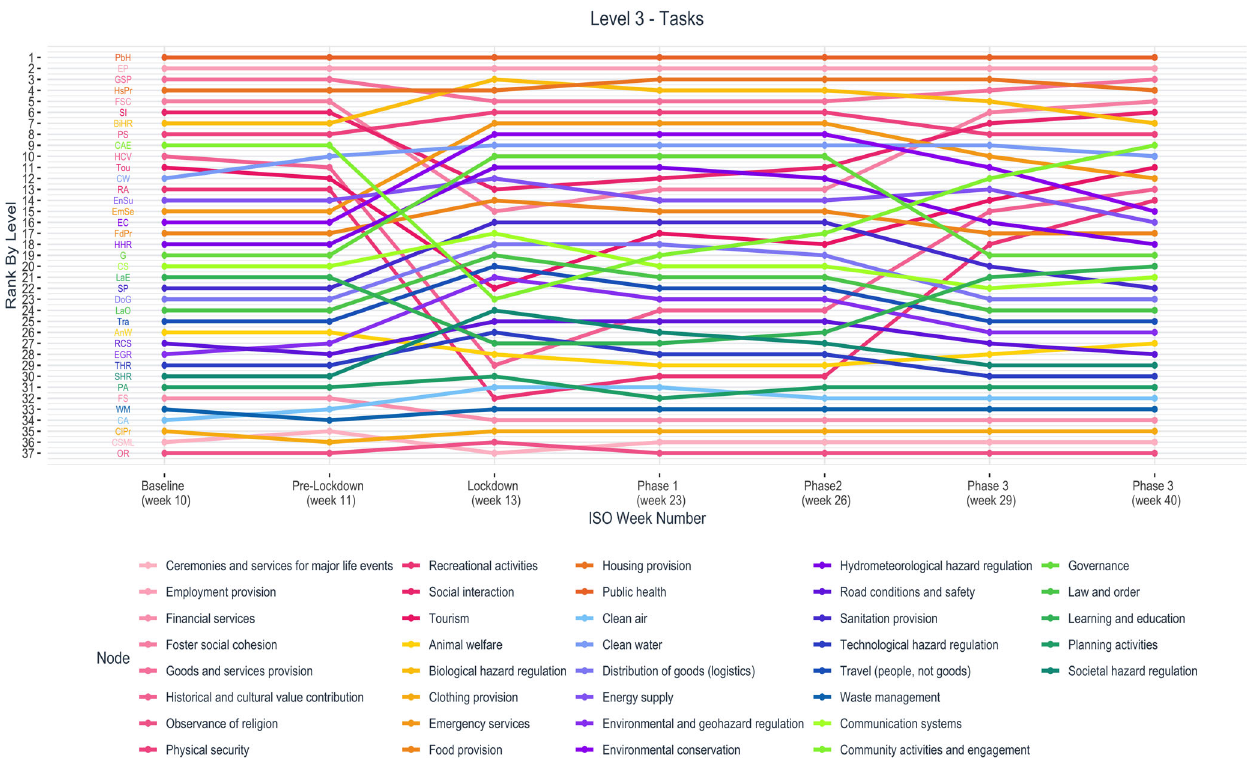
Fig. 9 Rank changes at key phases throughout the modelled period at Tasks level. All 100RC groups (rank con fi dence excluded).